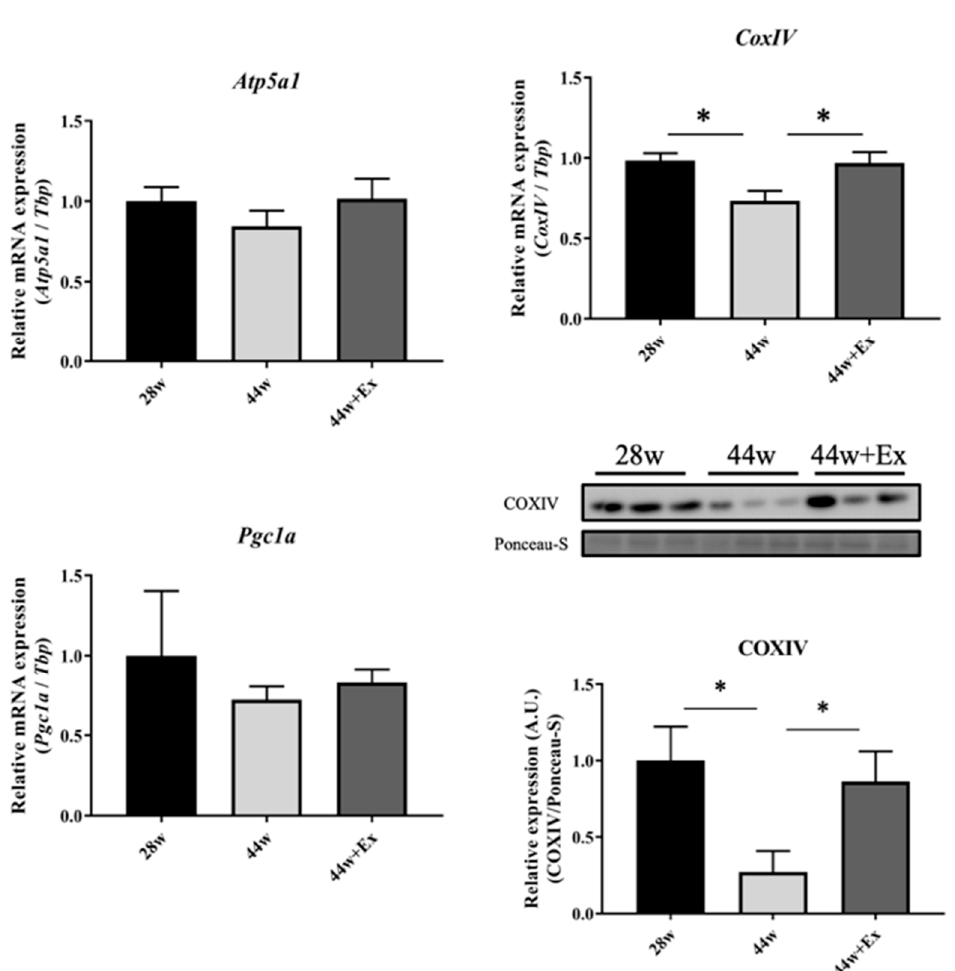
Figure 5. Genes and protein expressions related to mitochondrial function in gastrocnemius muscle. Genes expression level, related to mitochondrial function. Values are means ± SE ( n = 7–9). Proteins expression level, related to mitochondrial function. Values are means ± SE ( n = 6). 28 week old (28 w), 44 week old (44 w) and exercise (44 w + Ex). Single asterisk indicates significant differences ( p < 0.05).